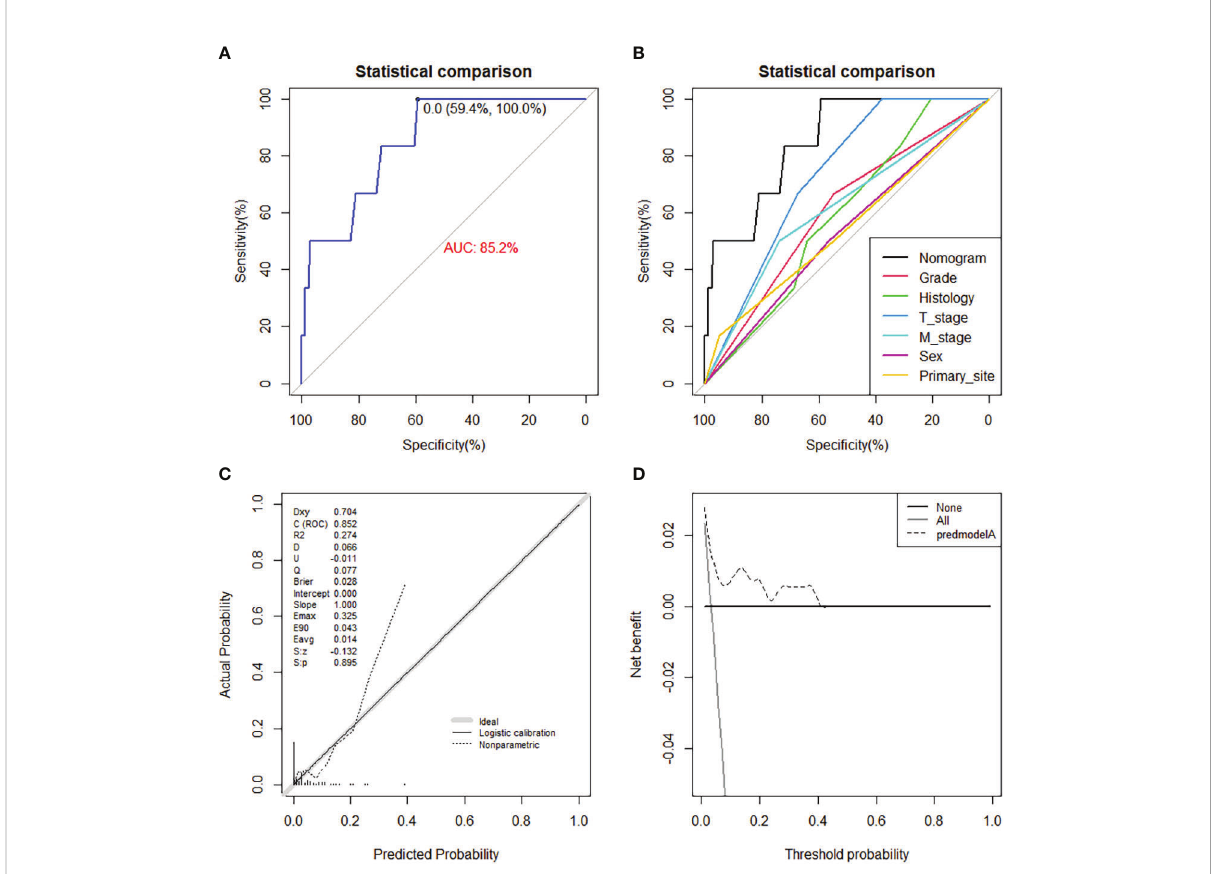
FIGURE 5 The ROC curve (A) , comparison of AUC between diagnostic nomogram and all predictors (B) , calibration curve (C) , and DCA curve (D) in the external testing set from Chinese